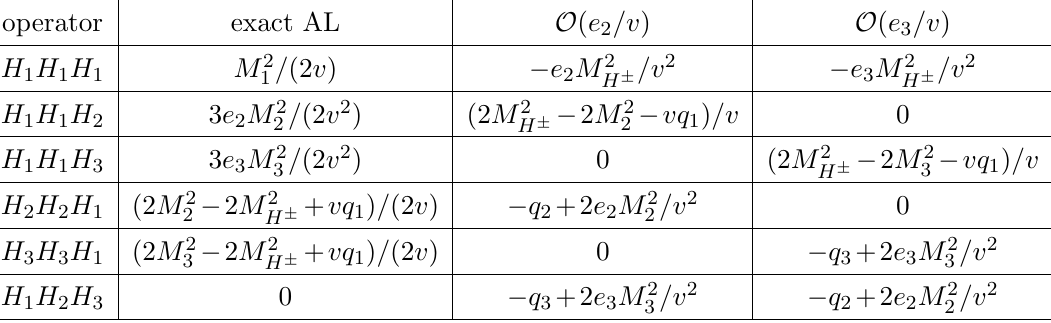
Table 4 . Coe(cid:14)cients of cubic scalar operators expanded around the alignment limit (AL), where the alignment is realized via decoupling, up to O ( e 2 ; 3 =v ). See caption to table 3. Note that e 2 M 2 and e 3 M 2 (for M = M 2 , M 3 or M ) approach a (cid:12)nite nonzero value in the limit of exact H (cid:6) decoupling (i.e., as M ! 1 ). Further explanations are provided in the